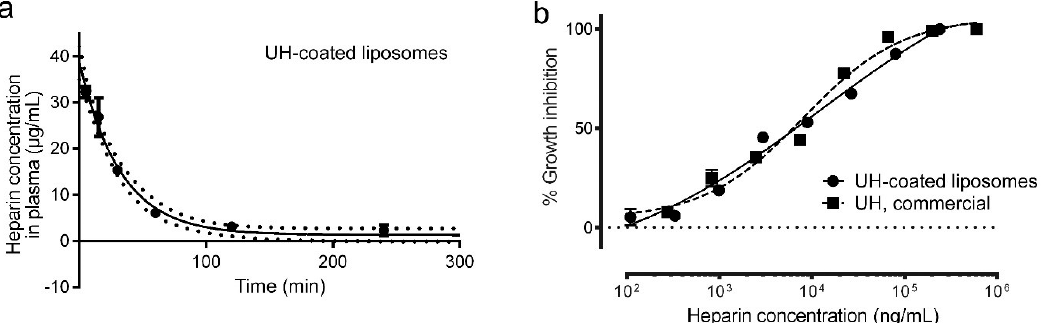
Figure 9. Characterization of circulation time and antimalarial activity of UH-coated liposomes. ( a ) Concentration of liposome-bound UH in mouse plasma along time following intravenous administration to 2 female mice for each time point. ( b ) P. falciparum growth inhibition activity assay of UH-coated liposomes and free